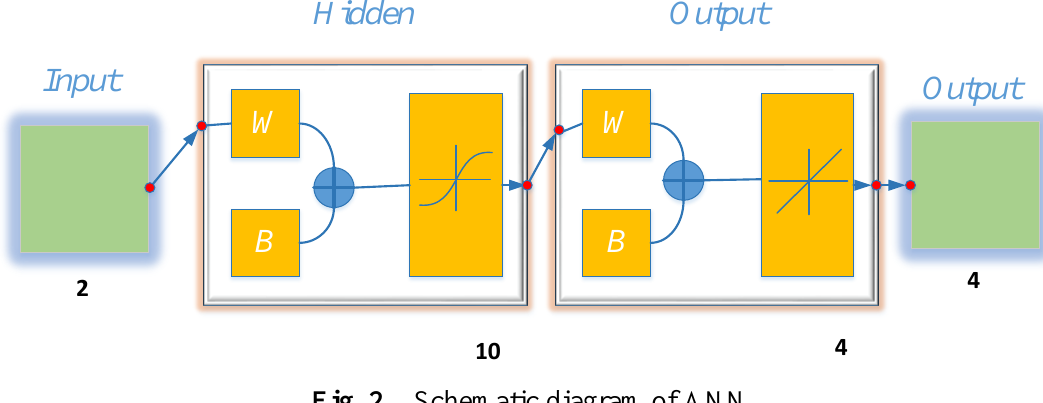
Fig. 2. Schematic diagram of ANN